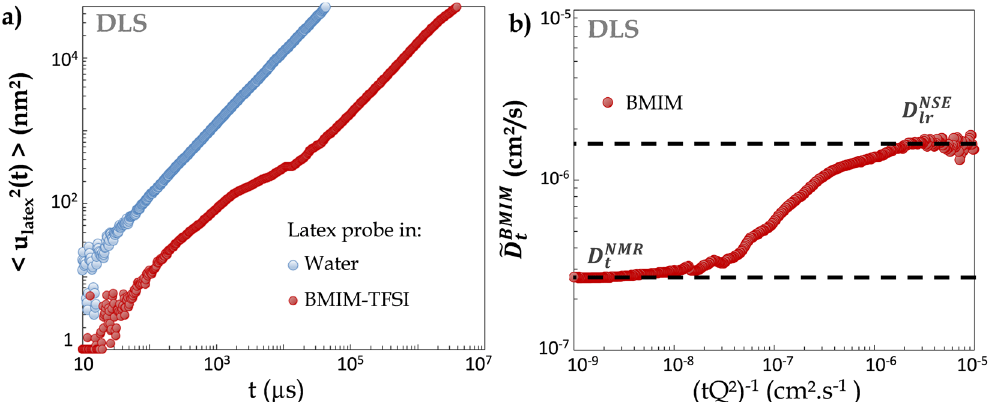
Figure 5. ( a ) Dynamic Light Scattering ( λ DLS = 647 nm, Q = 4.0 × 10 − 3 nm − 1 ): MSD of a nanometric probe (latex, 220 nm radius) embedded in water (blue) and bulk BMIM-TFSI (red). While in water the particle MSD is proportional to time (pure Fickian diffusion process), in the IL, around 10 4 μ s , the probe experiences a transient cage-like localization. Then for times larger than 10 5 μ s it recovers a Fickian behavior. This evidences the ∼ tBMIM transient nanometric structuration of the liquid. (b) We derive, (Eq. (5)), the molecular self-diffusion D coefficient of the BMIM cation. This DLS microrheology experiment is able to bridge the molecular NSE self- diffusion coefficient at short times and local scale ( D lrNSE ) to the same quantity as measured at the microscopic scale: D tNMR